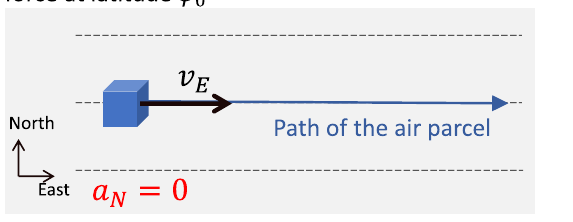
the Earth ’ s rotation and the parcel ’ s rotation with respect to the Earth, respectively. The conservation of absolute vorticity D ( ζ + f )/ Dt =0 determines a southward gra- dient of ζ , as denoted by the red shadow in ( c ). The gradient ’ s projection along the fl ow path l is typically not zero and would cause a tangential velocity v t . As an example, the path l in c is zoomed in at two green crosses, displayed in ( d , e ). These two crosses are associated with positive and negative gradients of ζ along l , respectively, as denoted by the red and pink arrows in ( d , e ). The black arrows v t denote the vector sums of the red and pink arrows bordering the crosses, both of which project zonally westward. The parcels at these crosses drift toward the green points in ( c ) and, visually, the path l drifts westward toward the dotted